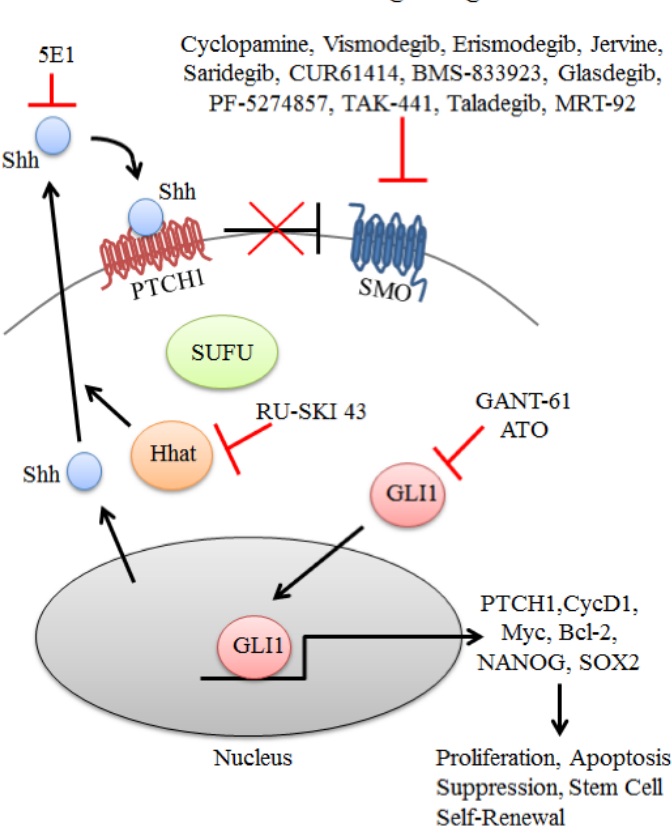
Figure 2. Hedgehog signalling pathway. Figure replicated from [55] under Creative Commons license, provided at https://creativecommons.org/licenses/by/4.0/ (accessed on 29 January 2023). Changes have been made to the figure legend and the figure has been